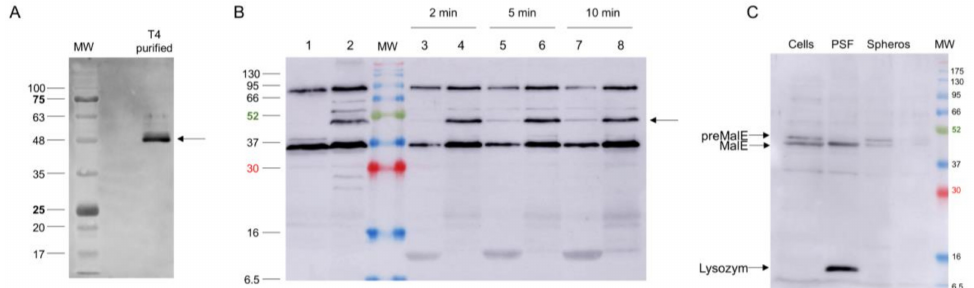
Figure 7. ( A ) Presence of gp5C in CsCl-purified T4 phage visualised by Western blot. ( B ) Fate of gp5C (bands marked with an arrow) from infecting phage at 2 (Lanes 3 and 4), 5 (Lanes 5 and 6) and 10 min post infection (pI; Lanes 7 and 8). Gp5C found in spheroplasts (Lanes 4, 6, and 8) and periplasmic fluid (Lanes 3, 5, and 7). For control, uninfected (Lane 1) and whole T4-infected cells (10 min pI; Lane 2) were analysed. ( C ) Fractionation of pre-MalE and MalE in periplasmic shock fluid (PSF) and in spheroplasts (Spheros) as